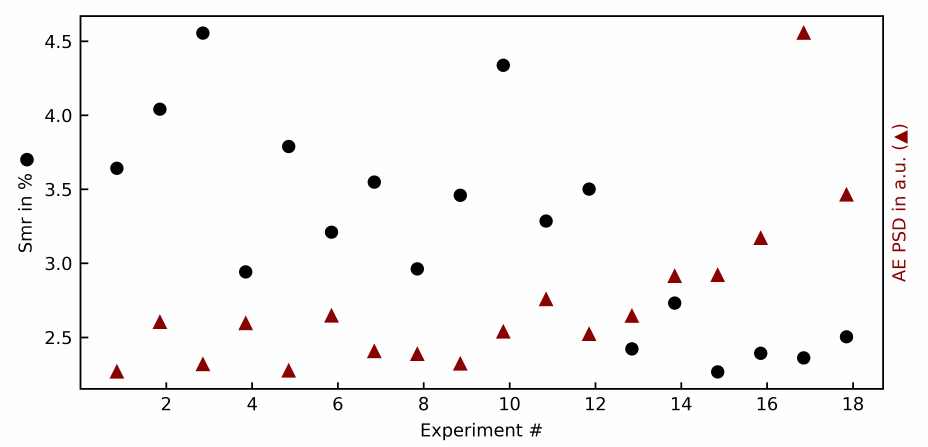
Figure 8. The integral of the AEPSD in relation to the surface bearing parameter